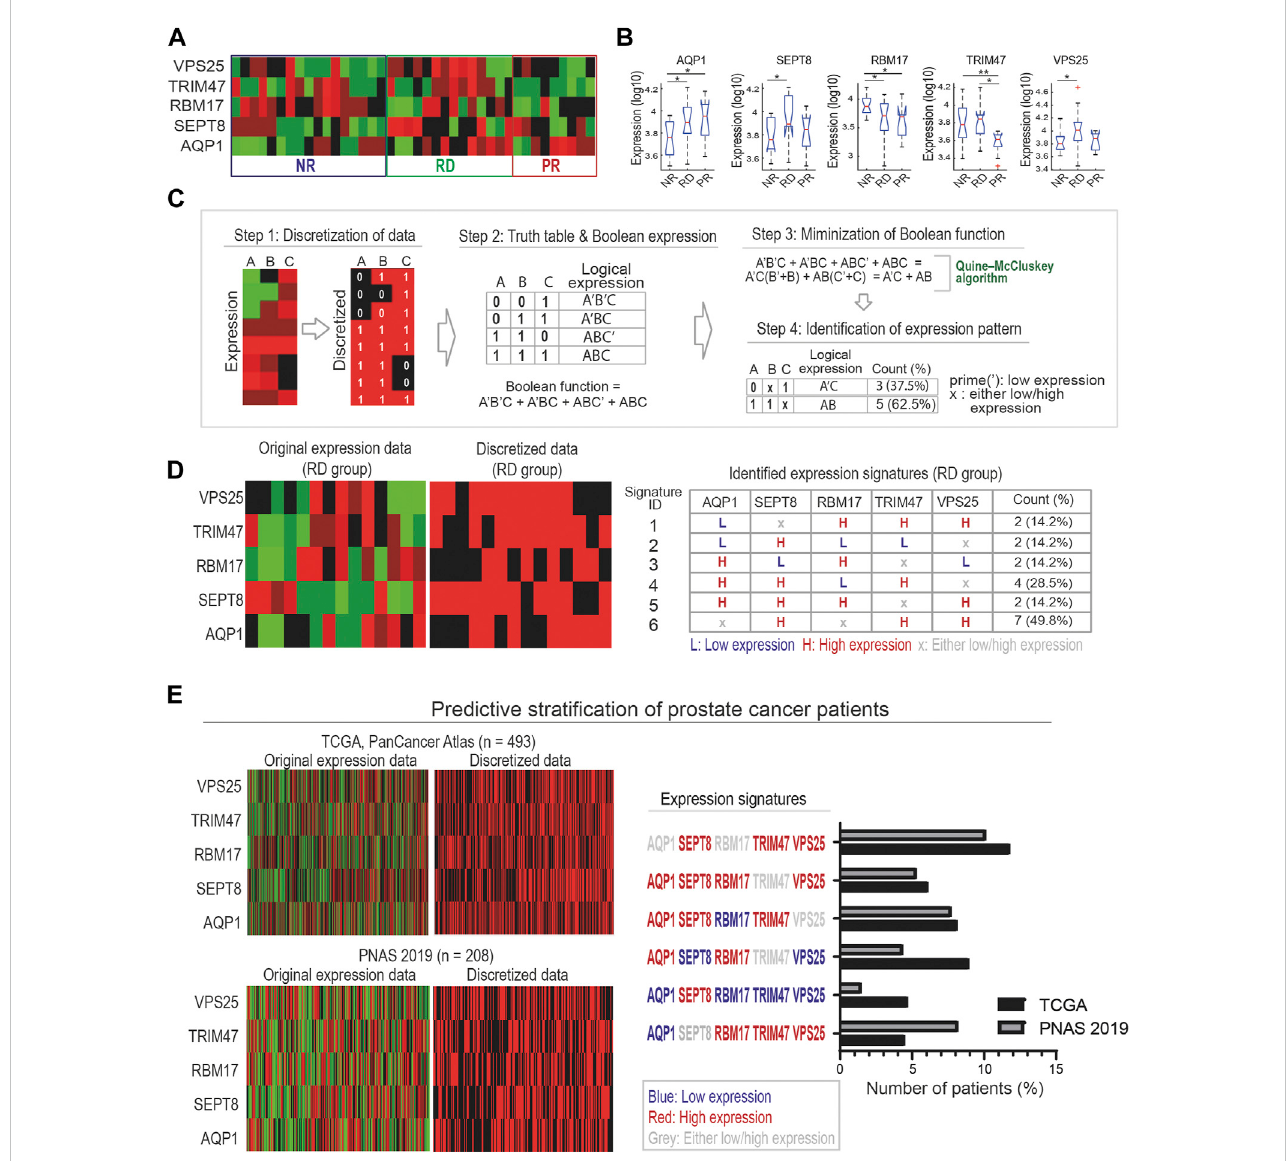
FIGURE 5 ABooleanalgebra-basedpipelineforderivationofbiomarkerexpressionsignatures. (A) Aheatmapdisplayingproteinexpressionlevelsofthe fi vemarker proteins in our identi fi ed compact panel across the discovery PDE cohort. (B) Traditional statistical analyses using t -test and boxplot to compare expression levels of individual marker proteins between the response groups (* indicates p -value < 0.05, ** < 0.01 (unpaired t -test), a red sign indicates outlier data). (C) A multi-step Boolean algebra-based pipeline designed to identify combinatorial expression signatures of the biomarkers for each response group. Step 1: Discretization of protein expression levels into binary values. Step 2: Generation of truth table for binarized expression levels that are then transformed into Booleanexpressions. Step3:MinimizationofBooleanfunctionsusingQuine-McCluskeyalgorithm,whichconvertsitintosimpler, morecompact forms.Step 4: Identi fi cation of expression signatures of biomarkers. (D) Left: the original expression levels and corresponding binarized values of the fi ve markers, shown for theRDgroup (leftpanels). Right: Listofsix identi fi edexpression signatures(ID1 – 6)ofthemarkerproteins,shownfor theRDgroup. Similardatafor theNR and PR groups is shown in Supplementary Figure S6. (E) Predictive strati fi cation of prostate cancer patients, using two patient cohorts from the cBioPortal (Materials and Methods). Left: the original gene expression levels and corresponding binarized values of the fi ve markers, shown for all the patients in each cohort. Right: number of patients identi fi ed with matching RD-speci fi c expression signatures shown in Figure